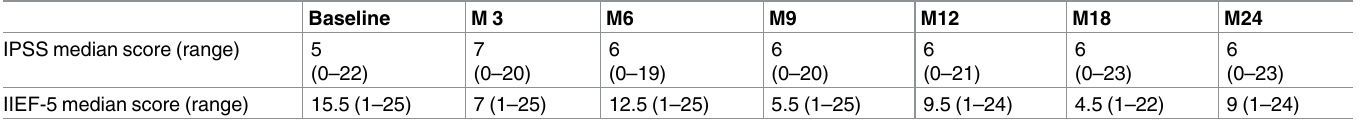
Table 3. Median IPSS and IIEF-5 scores at baseline and during